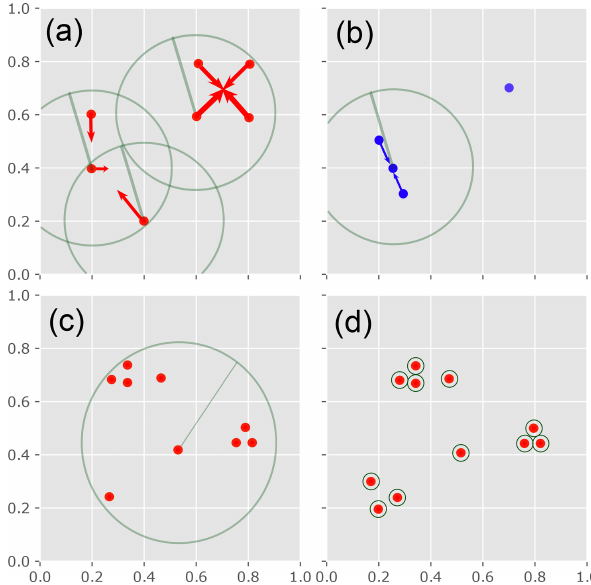
Figure A1. Schematic procedure of the mean shift algorithm in R 2 . (a) Red dots indicate hypothetical samples to be clustered. The cir- cles illustrate the flat kernel of the centered sample at first iteration. The bandwidth parameter is illustrated by the radius. The red ar- rows indicate the shift of the respective sample onto the geometric mean of all samples inside the current kernel. Note that three points on the left-hand side are shifted differently, as the upper and lower points do not lie in each other’s kernel. (b) Second iteration step after (a) . The blue dots are the shifted means from (a) and will be used as the input sample for the next iteration. The procedure finishes when no points can be “shifted” anymore. (c) Example of a large bandwidth (radius), which will result in only one cluster at convergence. (d) Example of a too small bandwidth, where no point will be shifted at